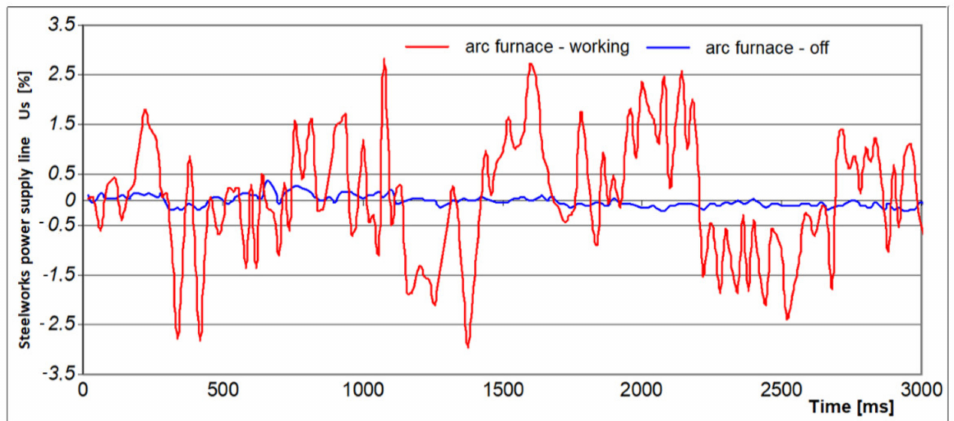
Figure 20. Changes in voltage fluctuations with arc furnace on and